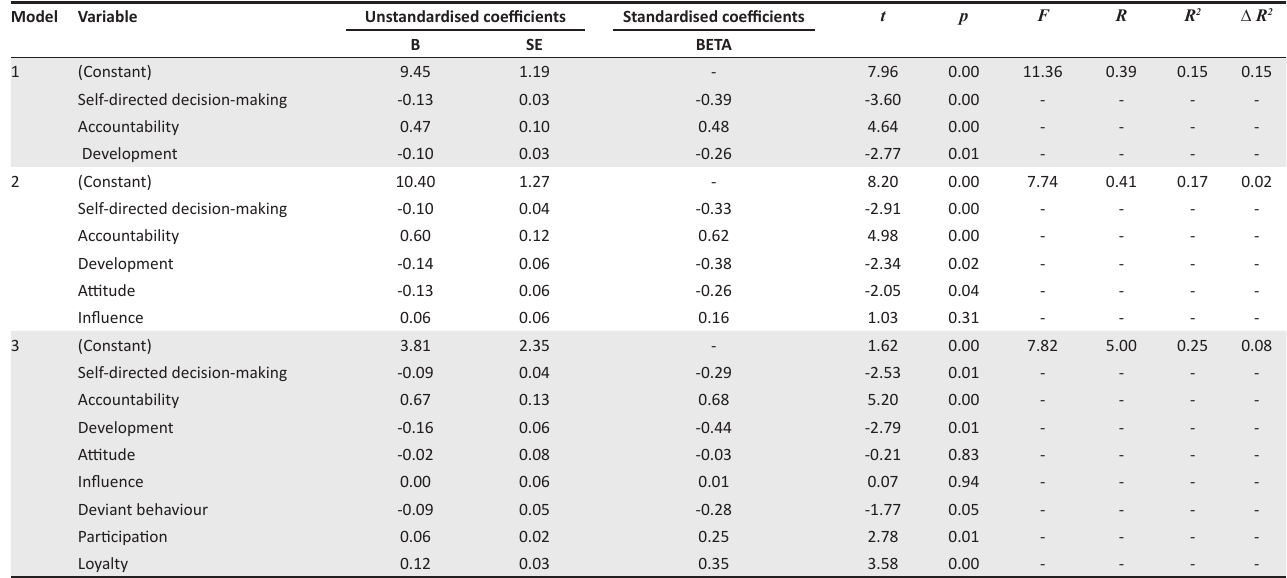
TABLE 7: Multiple regression analysis with turnover intention as dependent variable with leader empowering behaviour, psychological empowerment and organisational citizenship behaviour as independent variables. Model